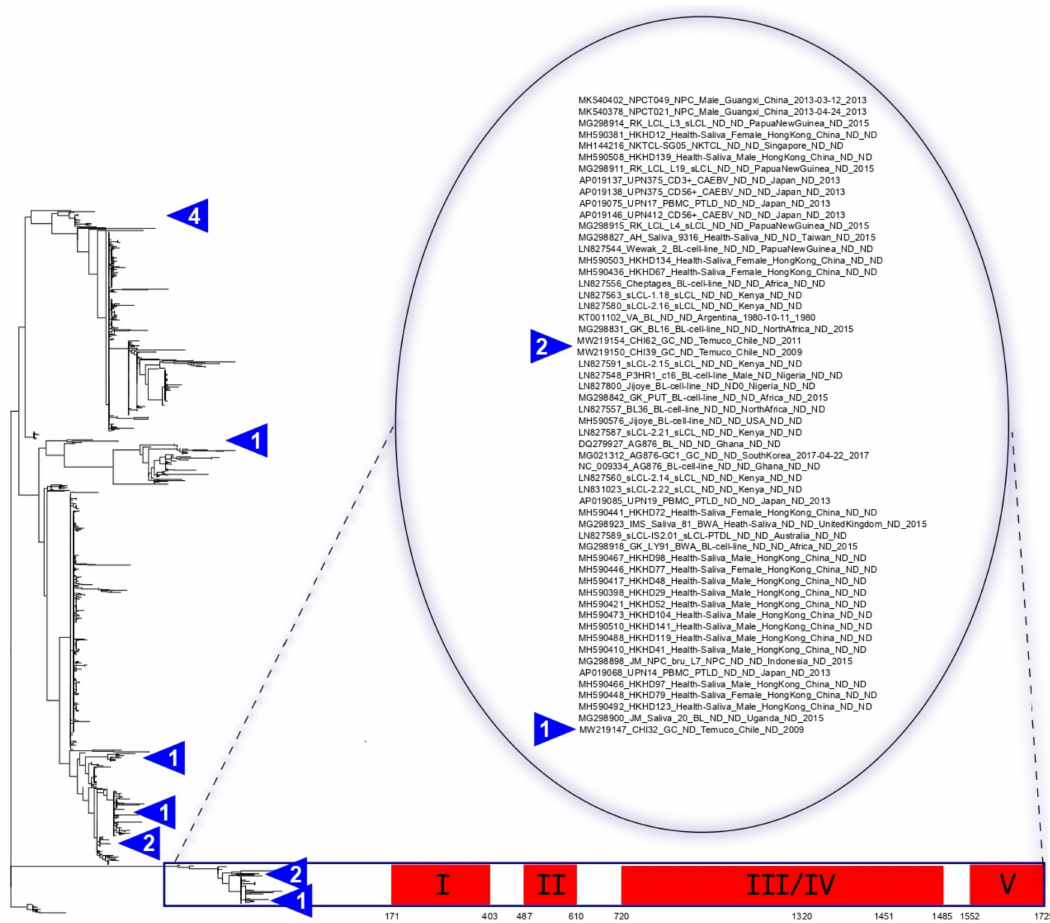
Figure 3. Phylogenetic tree and predicted recombination blocks in the EBNA3A gene. Phylogenetic tree reconstruction based on non-recombinant SNPs of 1006 EBV EBNA3A sequences on the Figure’s left side. The red blocks (I–V) indicate recombination areas common in multiple sequences that share descent at the bottom of the image. Below the red blocks are the positions corresponding to the EBNA3A nucleotide sequence. Sequences with predicted recombination blocks are in the zoomed area with their associated metadata. Only EBV-2 sequences had recombinant blocks predicted. Chilean sequences identified in this study are represented by blue triangles. The numbers inside the triangle indicate the number of